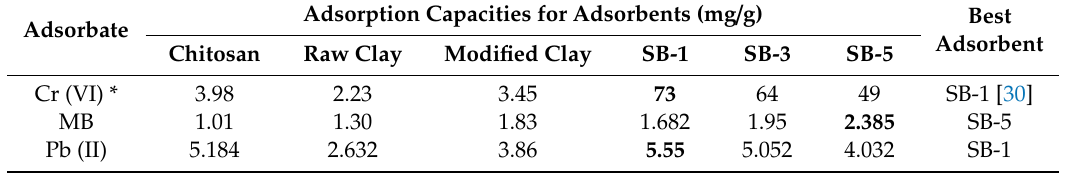
Table 2. Determination of adsorption capacities of composite beads for Cr (VI), Pb (II), and MB from their standard